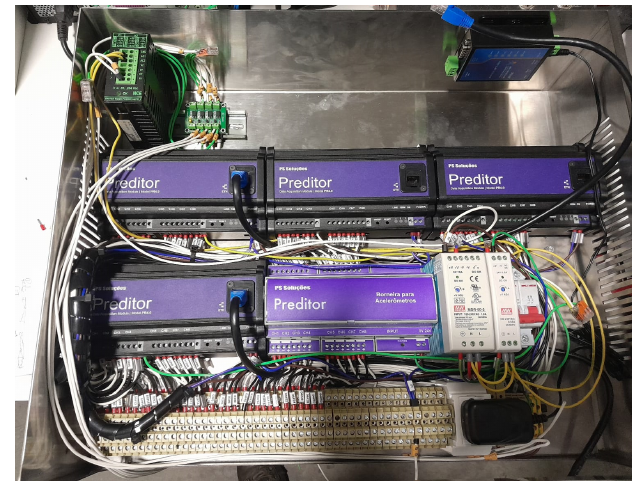
Figure 17. Preditor 4.0 data acquisition system.